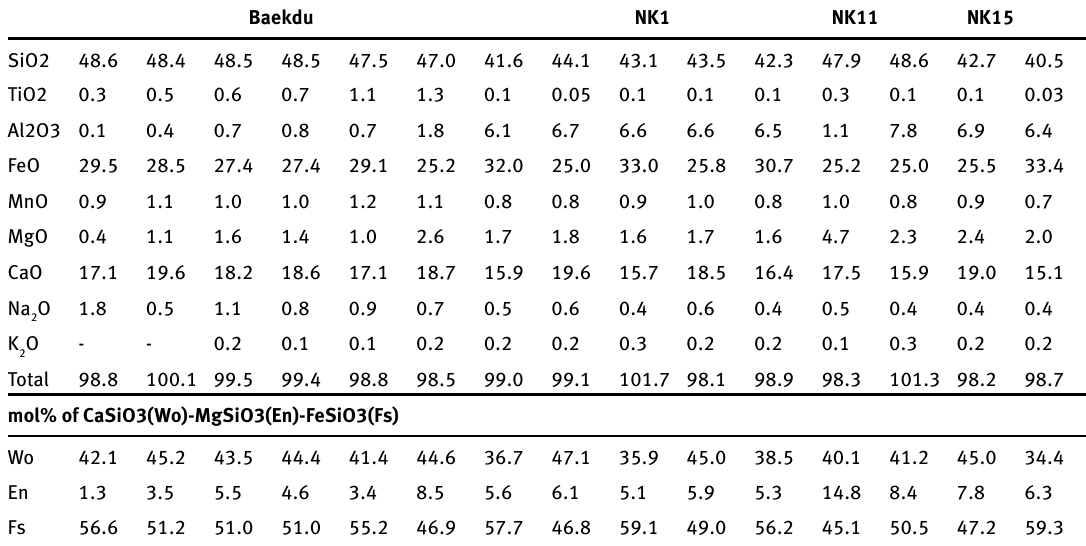
Table 1. Chemical compositions (wt.%) of clinopyroxene microlites in the Baekdusan obsidians. Baekdu NK1 NK11 NK15